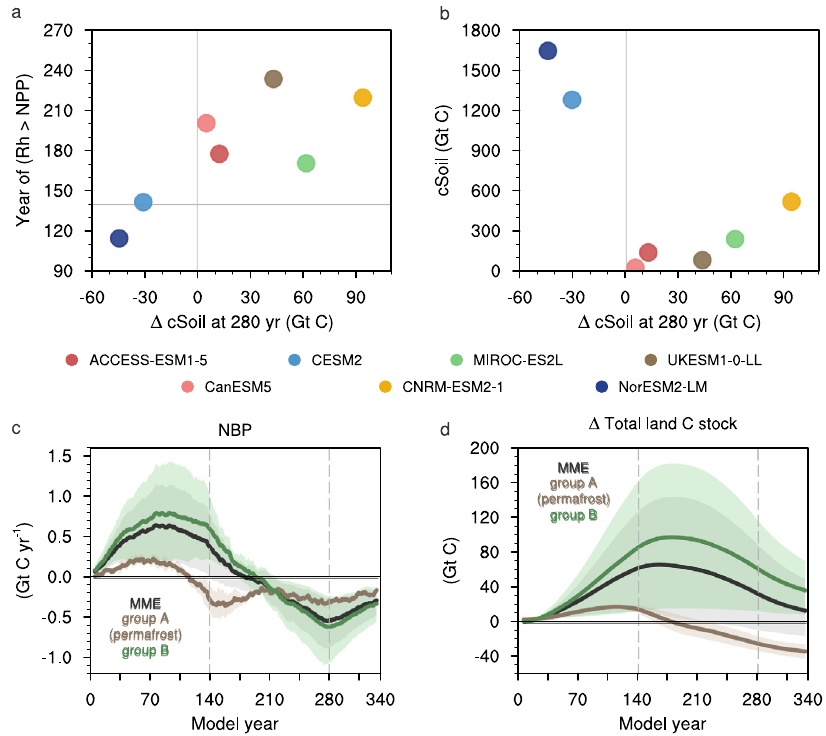
Fig. 4 Irreversible terrestrial carbon loss in the permafrost region. a , b Scatterplot of the cSoil anomalies at model Year 280 versus the model year when Rh exceeds NPP ( a ). Scatterplot of the cSoil anomalies at model Year 280 versus the mean state of cSoil in the control simulation ( b ). c , d Time-series of annual NBP ( c ) and total land C stock anomalies ( d ): the MME mean (black), the average value from ESMs, including permafrost representation (brown, group A), and the average value for the other models (green, group B). The shadings represent the 95% con fi dence intervals based on the bootstrap method. The beginning and end of CO 2 changes are indicated by the gray dashed vertical line. All values are averaged over the permafrost region above 60°N and smoothed by the 11-year moving